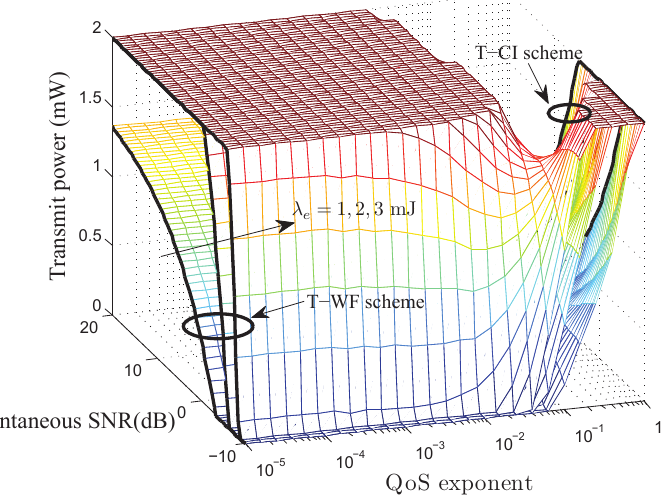
Figure 3. The QoS-driven power control policy for battery-finite energy harvesting based wireless sensor networks with m = 2, γ = 5 dB, and B max = 2